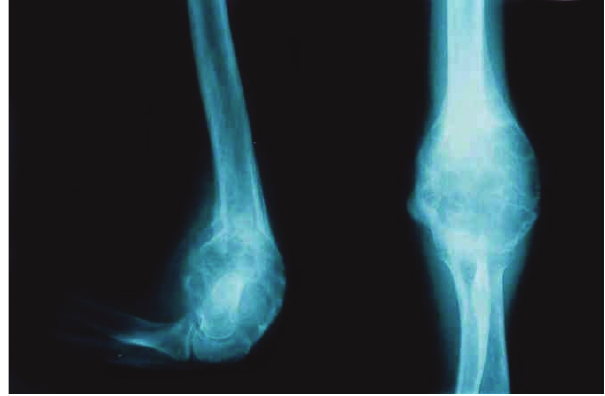
Figure 1 - Osteoblastoma of the distal humerus showing cortical expansion (Case 25, atypical